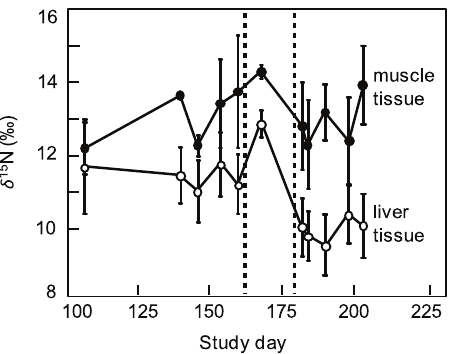
Figure 4. Time series of black bream muscle and liver d 15 N isotope composition. Time series of mean d 15 N isotope ( % ; error bars show 6 1 SD) values of black bream Acanthopagrus butcheri liver (empty circles) and white muscle tissue (filled circles) collected in Lake King, Australia. Area bounded by vertical dotted lines indicate the intervening period between N. spumigena bloom collapse (study day , 155) and depletion of liver d 15 N values. The x-axis shows the number of days elapsed since 1 September 2011 (study